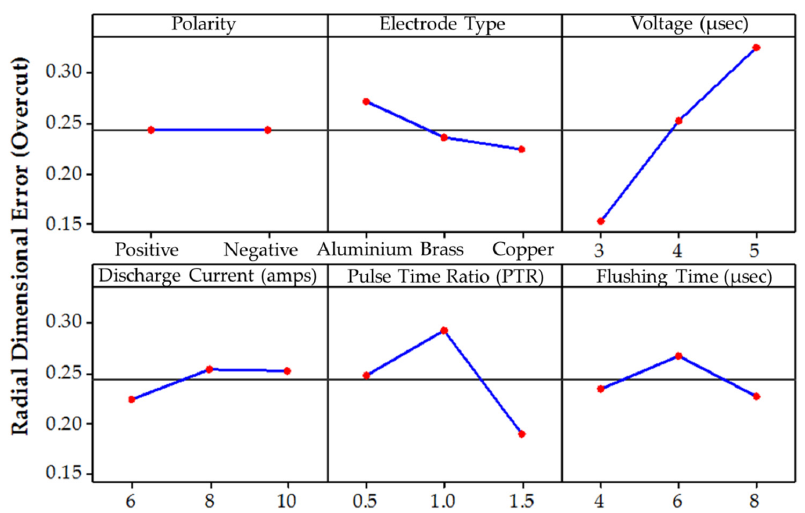
Figure 5. Average experimental results obtained for the radial dimensional error by varying each control parameter for the EDM process including graphene-based dielectric fluid.